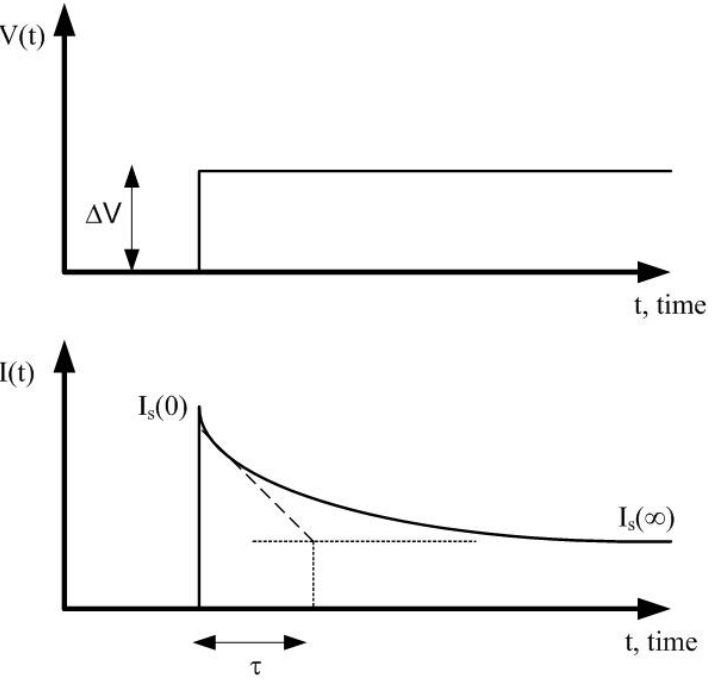
Figure 3. Current response to a voltage step applied at the input bias between the working and reference